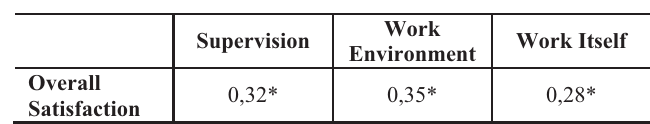
Table 5: Spearman correlations between defined